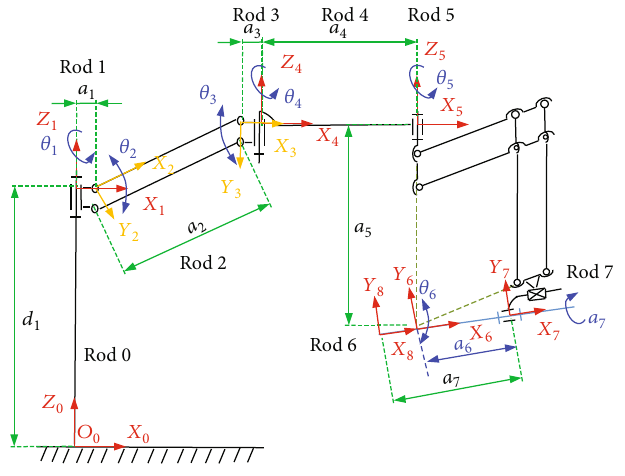
Figure 7: The kinematics coordinate system. Table 1: D-H parameters of manipulator.